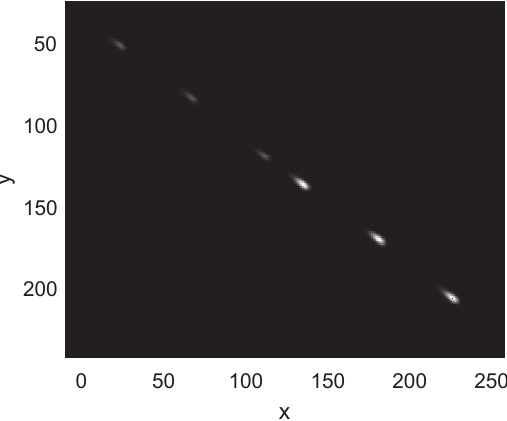
Figure 9. Snapshots of a tracking scene of target intensity